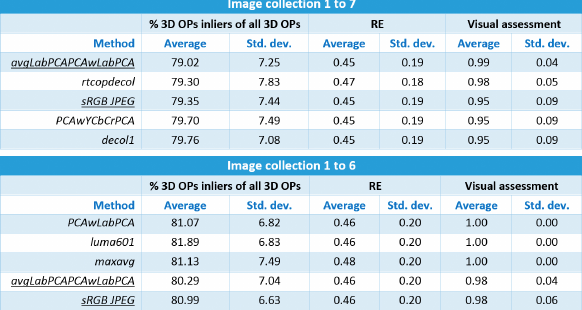
Table 4. The five ‘best’ decolourization approaches, based on the visual assessment of the SfM output and total RE.